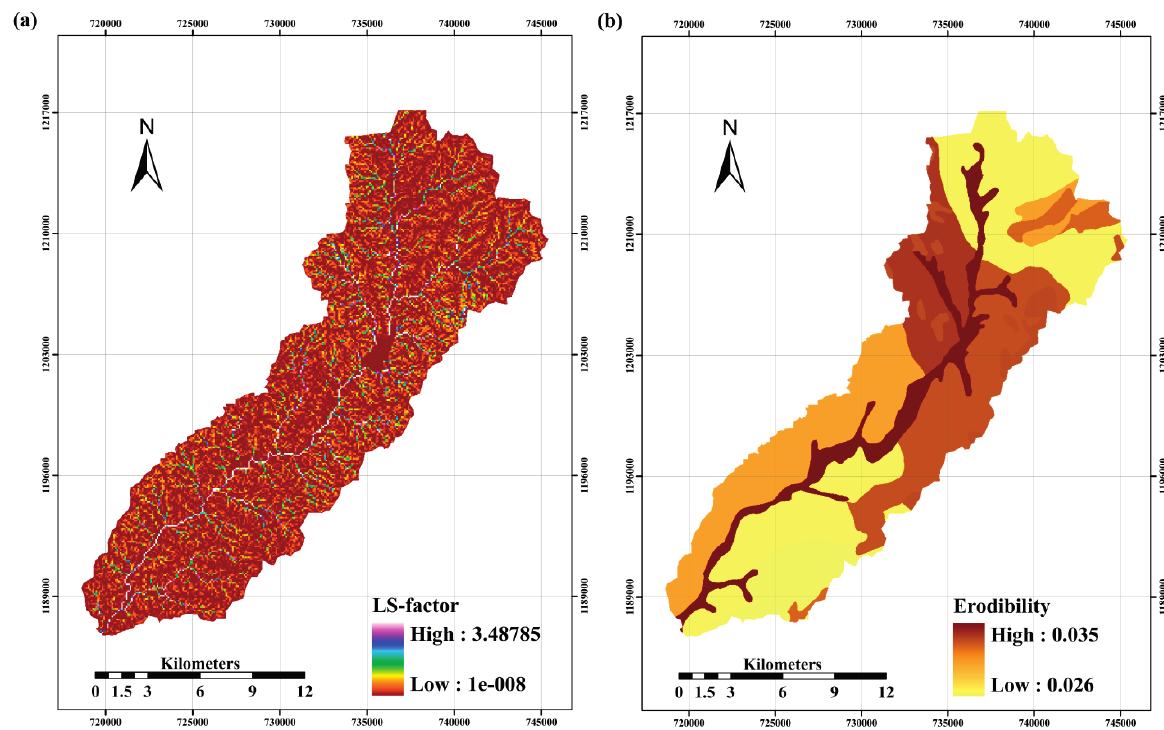
Figure 6. ( a ) LS-Factor %; ( b ) soil erodibility factor-t·h·MJ − 1 ·mm − 1